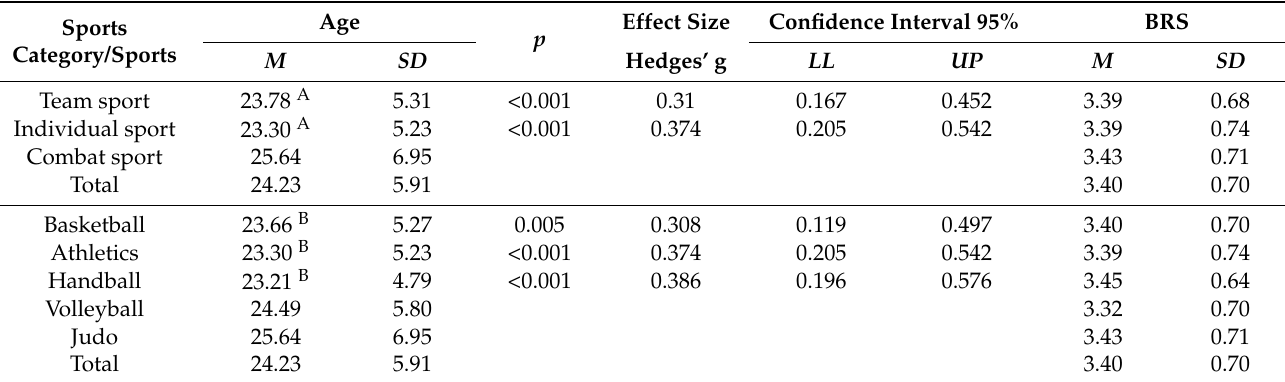
Table 3. Age and resilience comparisons by sport and sport